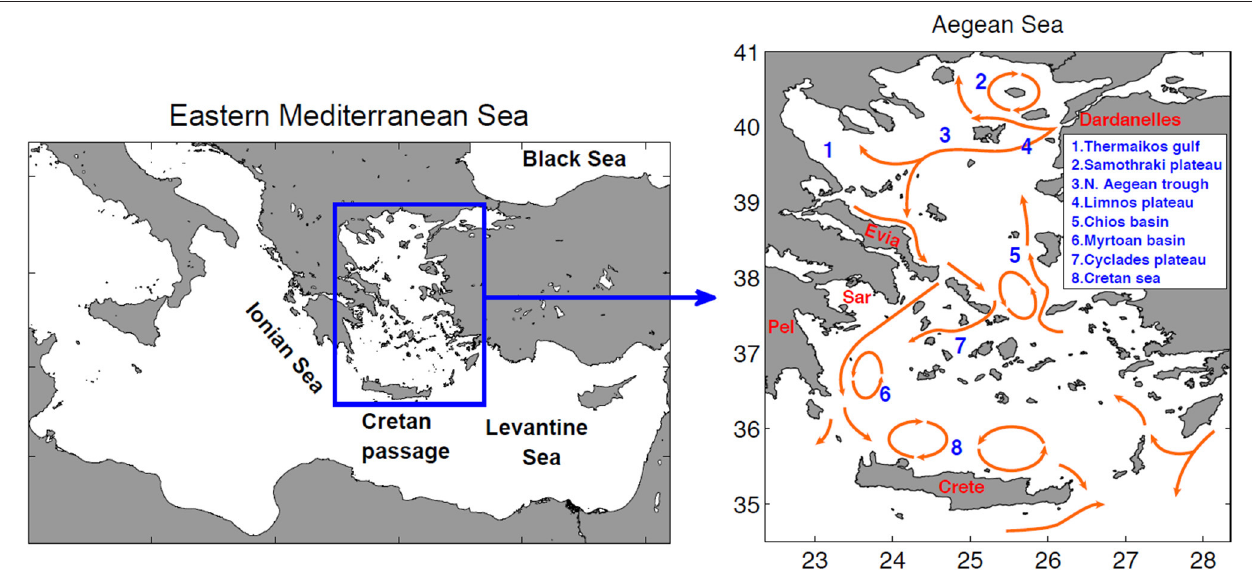
FIGURE 1 | Map of the Aegean Sea. Numbers 1 to 8 denote major basins, gulfs and plateaus, and abbreviations denote place names: Peloponnese (Pel), Saronikos Gulf (Sar), Evia island, Dardanelles strait and Crete island. Schematic representation of the general Aegean Sea upper circulation is also shown ( Map modified after Nittis and Perivoliotis, 2002; Nittis et al., 2003; Olson et al.,